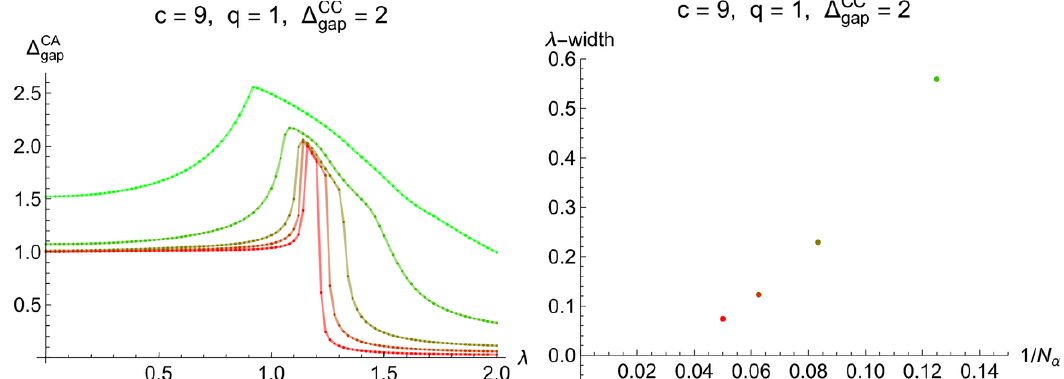
Figure 11. Left: upper bounds on the gap in the CA channel (cid:1) CA for the gap in the CC channel gap (cid:1) CC = 2, as a function of the chiral ring coe(cid:14)cient (cid:21) , in the case of c = 9 and q = 1, at derivative gap orders 4, 8, 12, 16, 20 (green to red). Right: the width of the peak plotted over inverse derivative (cid:21) l , where (cid:21) r is the value of (cid:21) at which (cid:1) CA order. The width is de(cid:12)ned as (cid:21) r = 1 on the right gap (cid:0) edge, and (cid:21) l is the value of (cid:21) at which (cid:1) CA = 1 : 5 on the left edge. gap